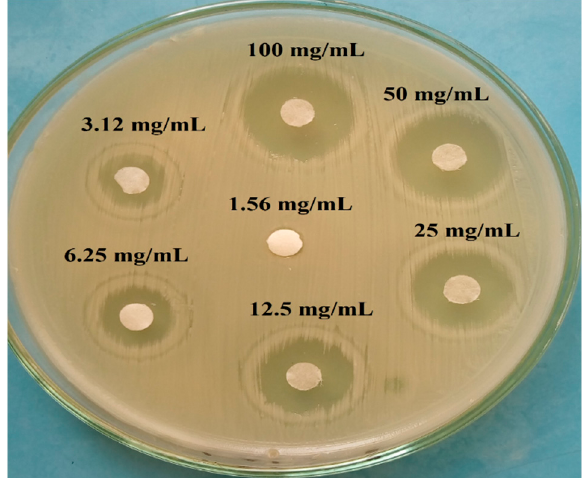
Figure 3. Determination of the minimum inhibitory concentration (MIC) of HO extract against S. aureus EMCC1351.